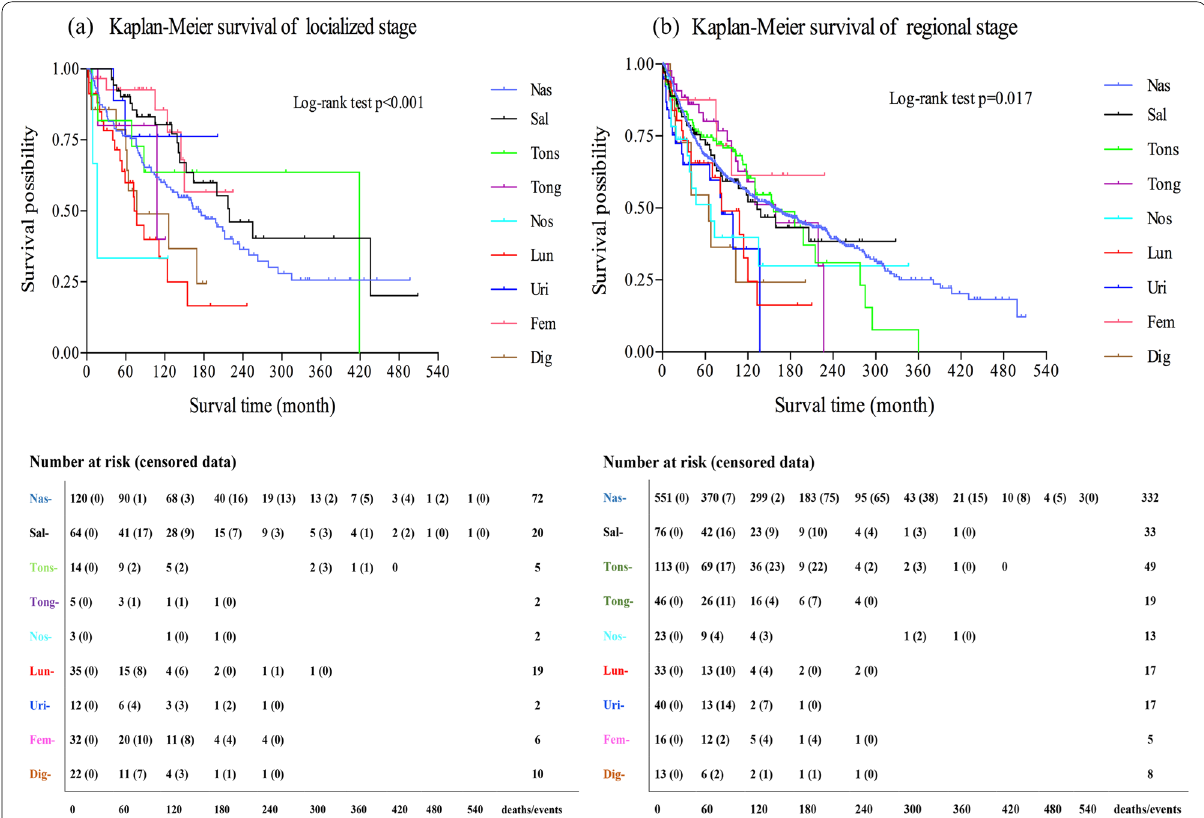
Fig. 3 The overall survival curves of LELC patients by different anatomic sites. a Kaplan–Meier curves of OS and at-risk table for patients presenting with localized disease, by anatomic site. b Kaplan–Meier curves of OS and at-risk table for patients presenting with regional disease, by anatomic site. Nas, nasopharynx; Sal, salivary gland; Tons, tonsil; Tong, tongue; Nos, nose, nasal cavity and middle ear; Lun, lung and bronchus; Uri, urinary bladder; Fem, female genital system; Dig, digestive